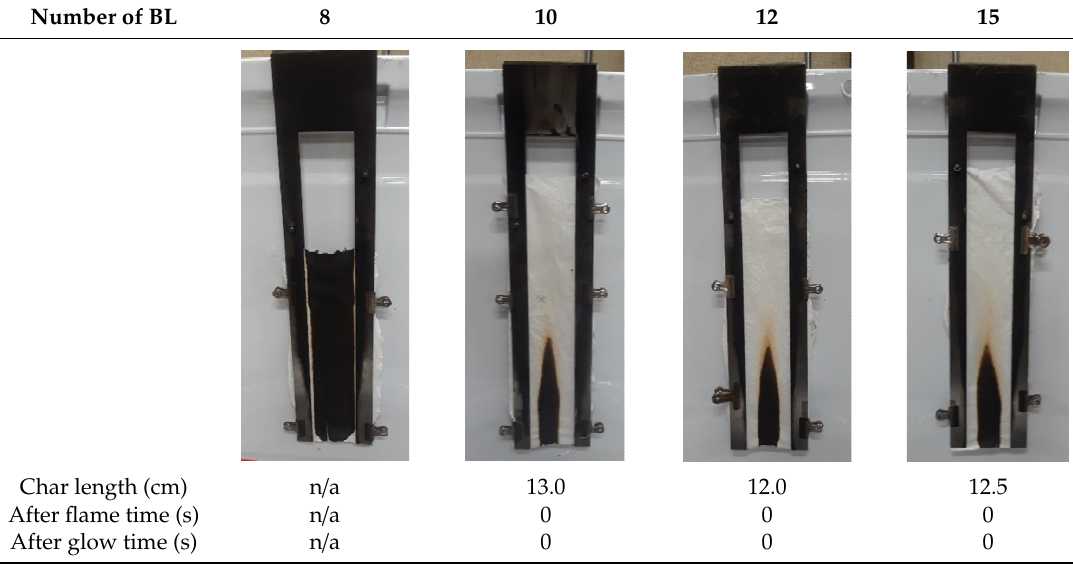
Table 2. Vertical flame test results for cotton samples treated with varying number of bilayers. Number of BL